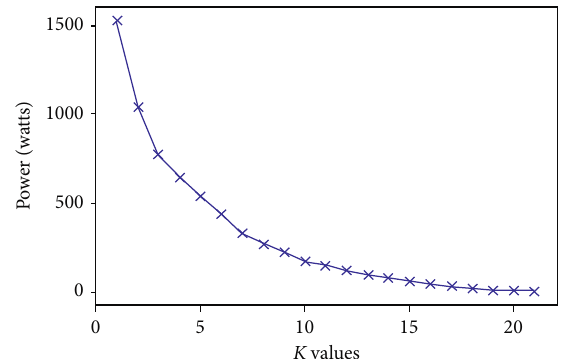
Figure 8: Elbow method to determine the optimal value of K for the